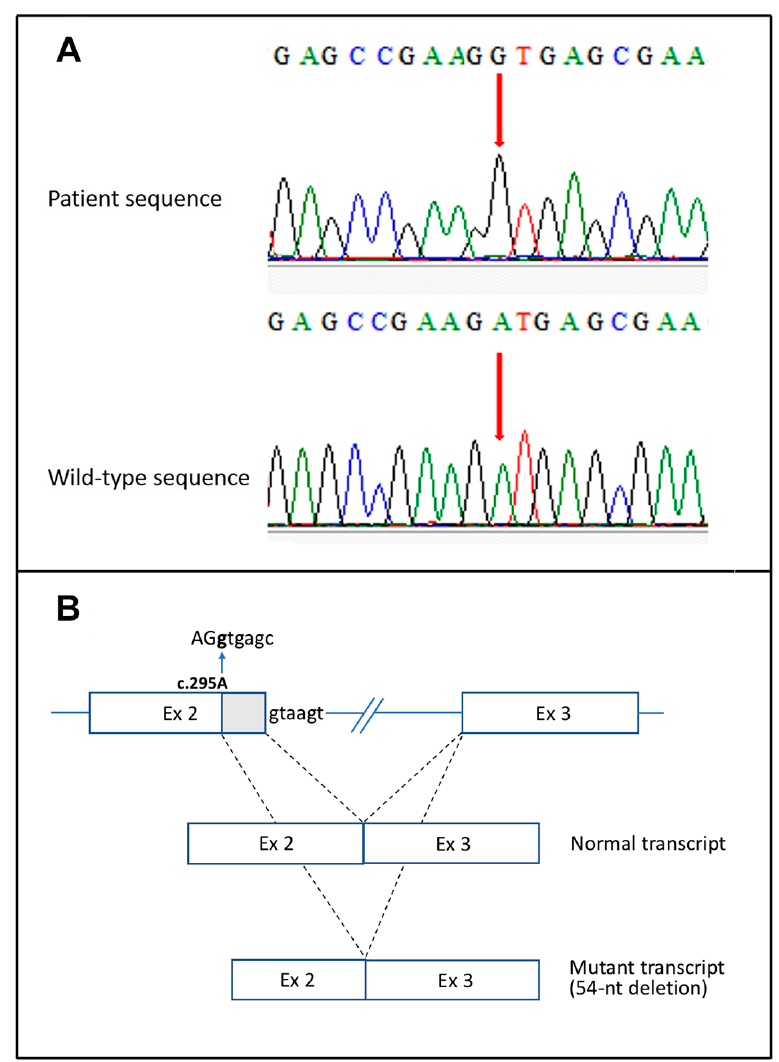
Figure 3. ( A ) Electropherograms of the direct sequence of exon 2 TTC7A gene: the homozygous missense mutation c.295A>G (p.M99V) is shown (red arrows). ( B ) Potentially altered splicing due to the c.295A>G mutation. The mutation creates a new donor splice site (AGgtgagc) in a late exonic position that results in an aberrant exon 2 definition. Usage of this cryptic donor site leads to a mutant in-frame transcript shortened of 54 nucleotides (p.M99_S116del). Normal splicing by the naturally occurring donor site (gtaagt) is shown for comparison.